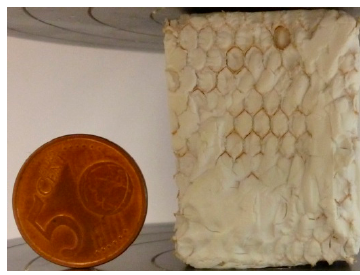
Figure 8. Low-flexible silica aerogel (SA2) with aramid honeycombs C1-3.2-29.